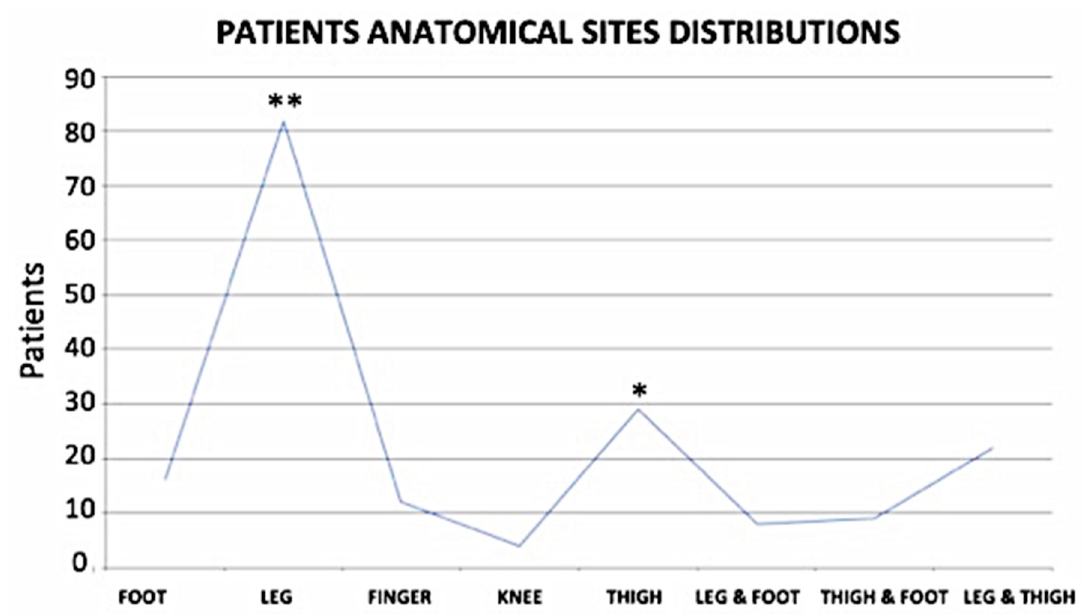
Figure 5. Patient Anatomical site distribution by wound size. * p < 0.05; ** p < 0.01.